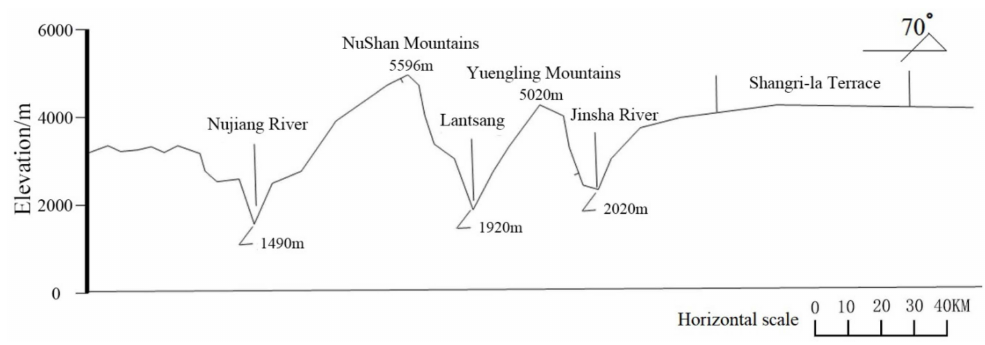
Figure 5. Topographical profile of the Three Parallel